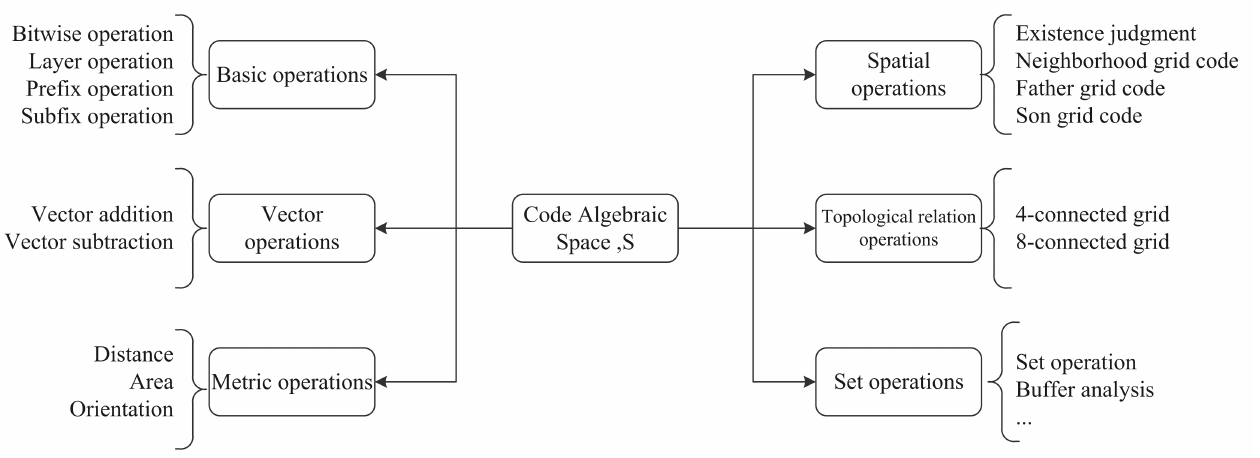
Figure 6. Algebraic operation framework for